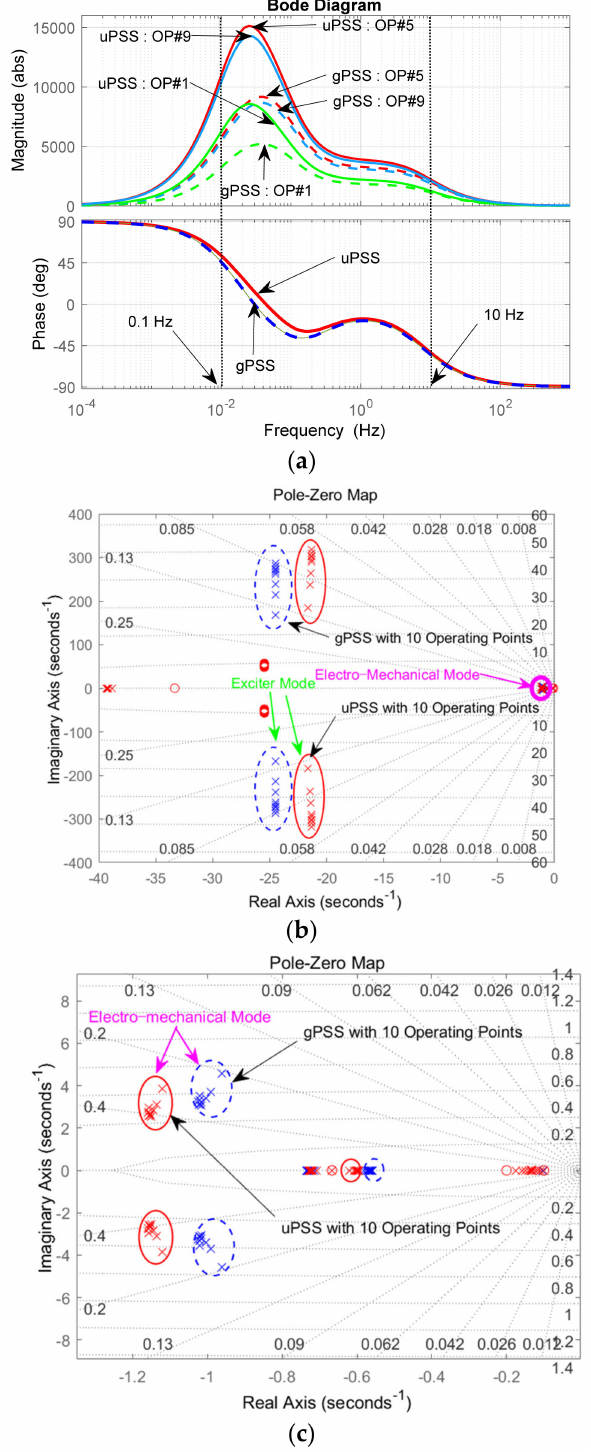
Figure 9. µ PSS stability analysis by frequency-domain characteristic of the GEP and SMNB models (solid line: with µ PSS; dashed line: with gPSS): ( a ) Bode diagram of the GEP model with 3 operating points, ( b ) pole zero map of the SMNB model with 10 operating points, and ( c ) pole location of the electro-mechanical mode of the SMNB model with 10 operating